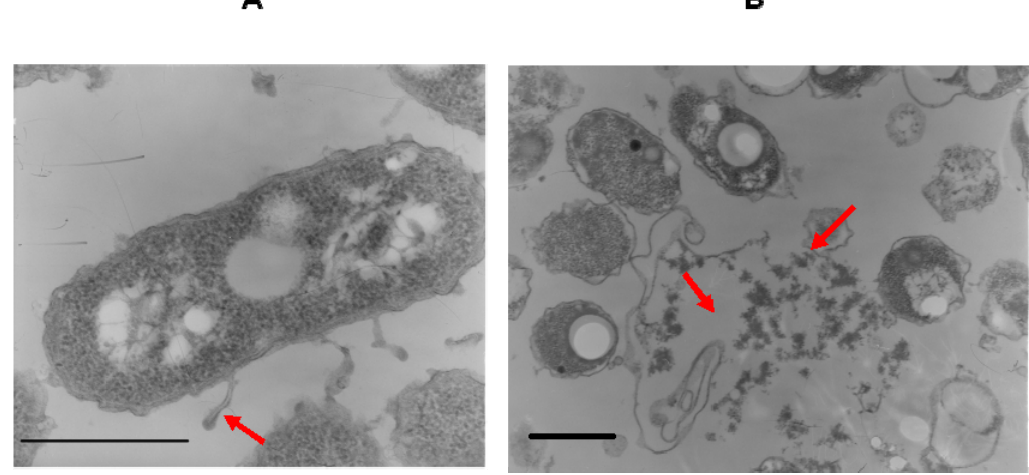
Figure 2. Electron micrographs showing EPS accumulation around H. almeriensis M8 T cells during exponential growth ( A ) and stationary phase ( B ). Bars = 1 µm. Arrows indicate the EPS of the